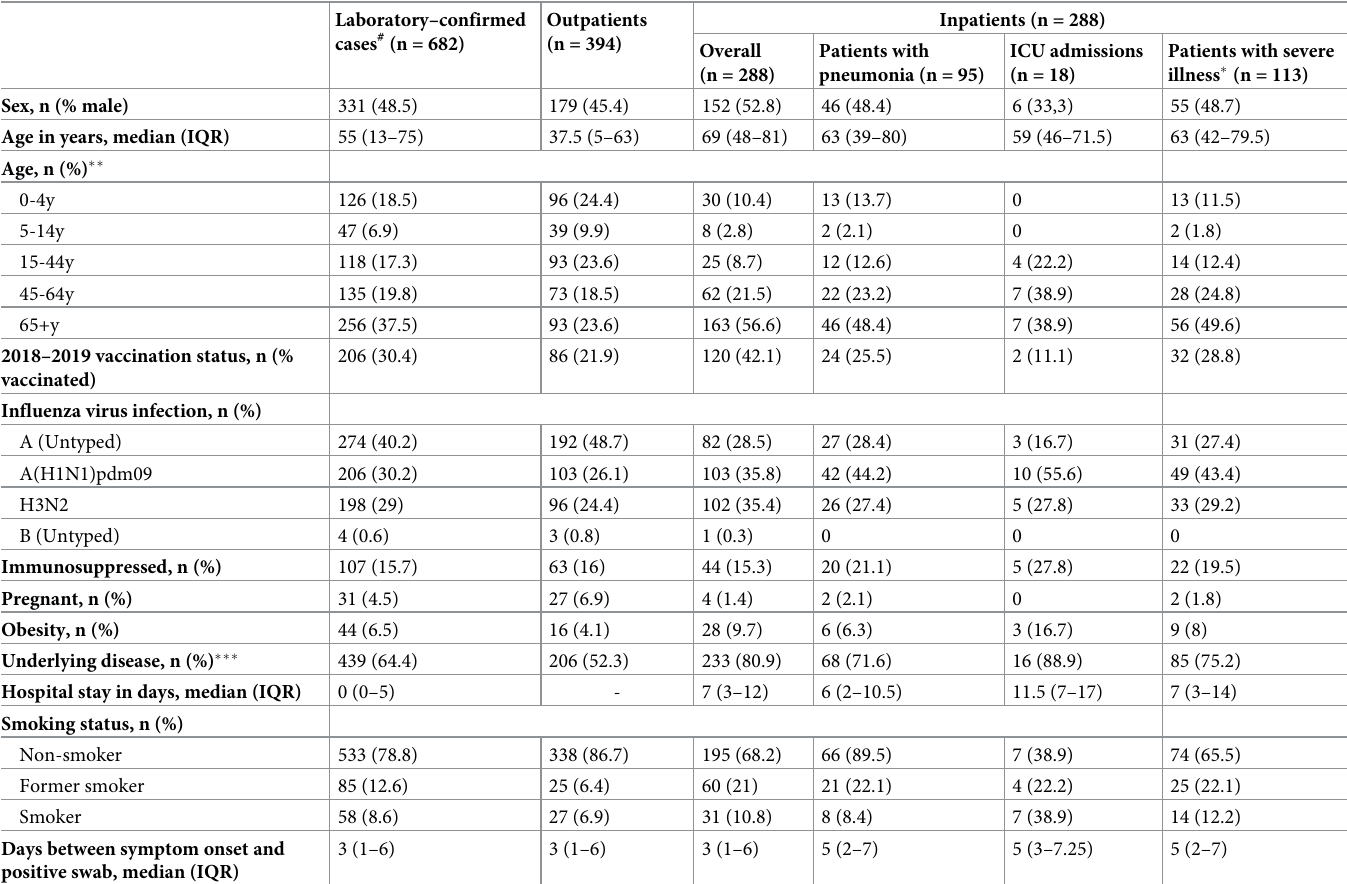
Table 1. Baseline characteristics of laboratory-confirmed influenza attended during the 2018–2019 influenza season (n =